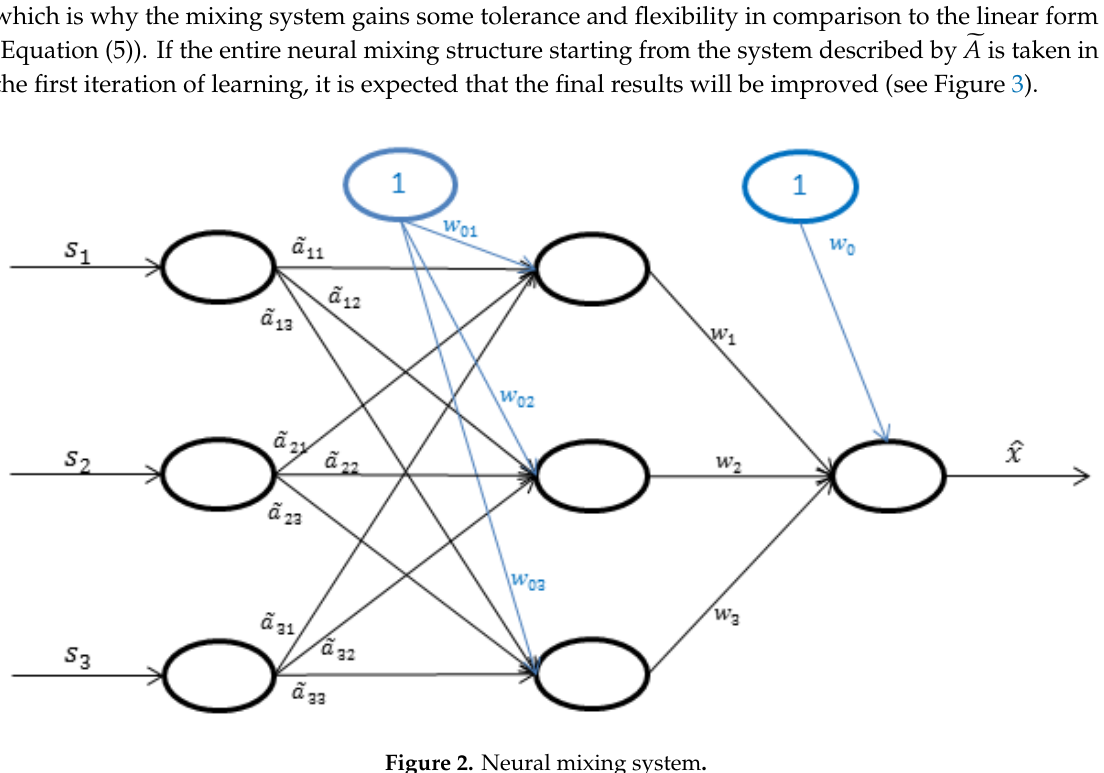
Figure 2. Neural mixing system .